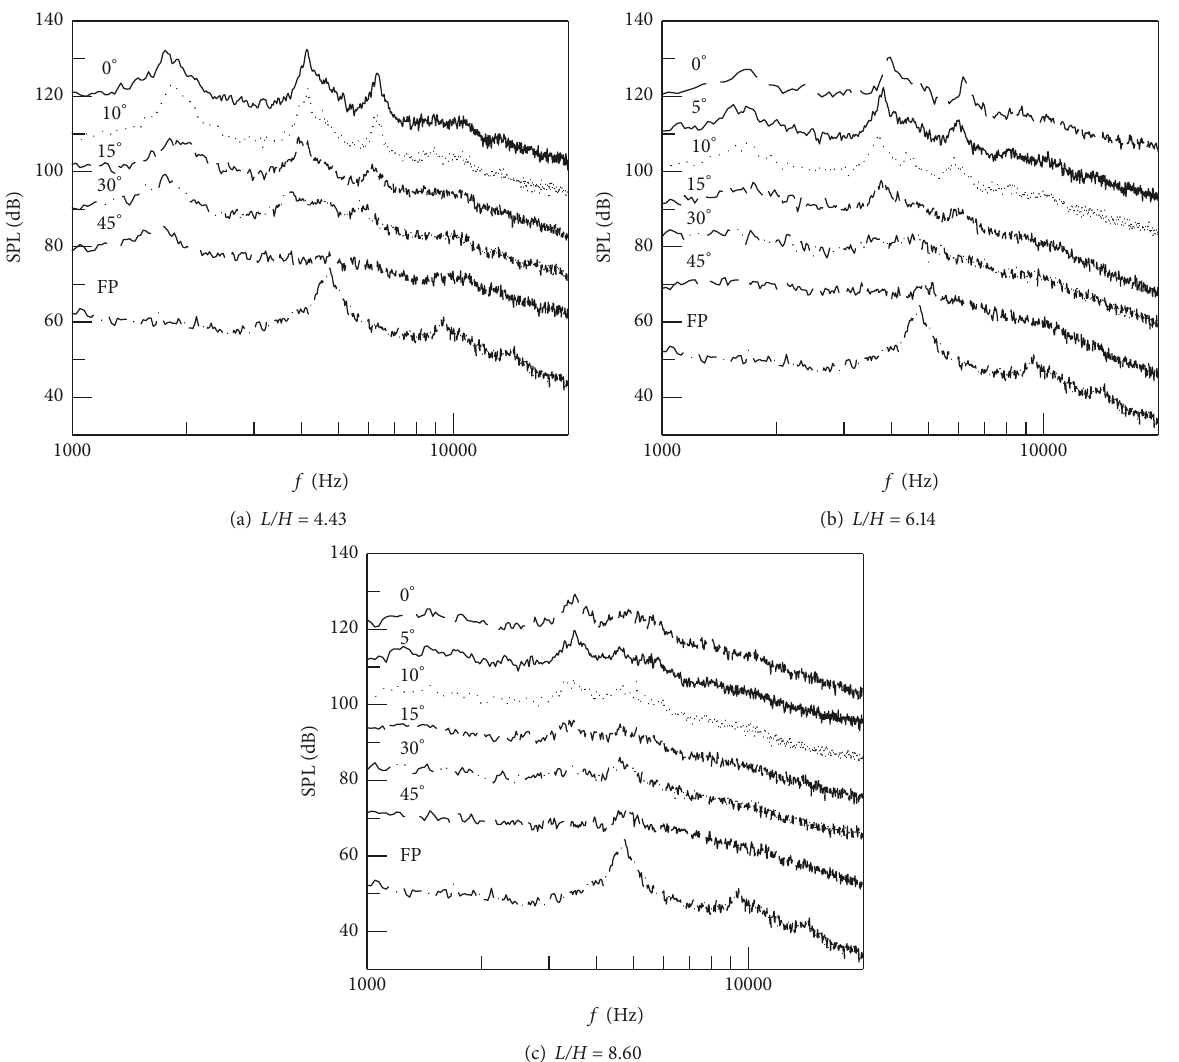
Figure 11: Distributions of the power spectral density for M = 0.83 and x/L = 0.919. (Each plot is offset by 10 dB along the amplitude axis to give greater clarity. The uppermost plot has its original